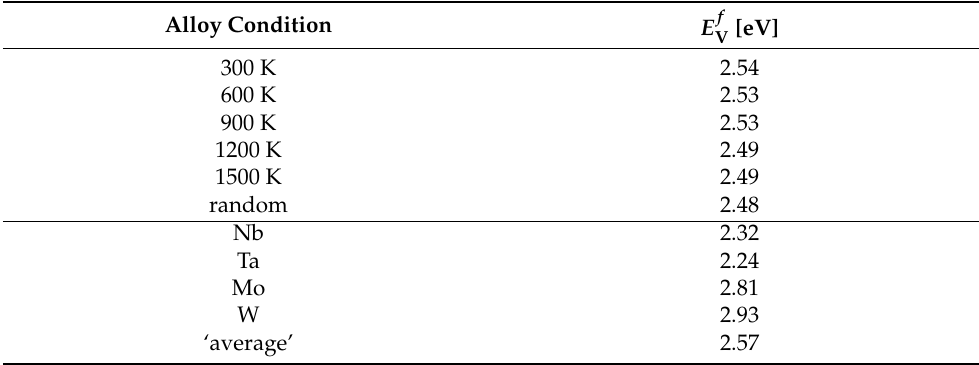
Table 3. Statistical averages of vacancy formation energy distributions of Nb-Mo-Ta-W and vacancy formation energies of the pure constituents. The ’average’ represents the weighted average of vacancy formation energies of Nb, Ta, Mo, and W.